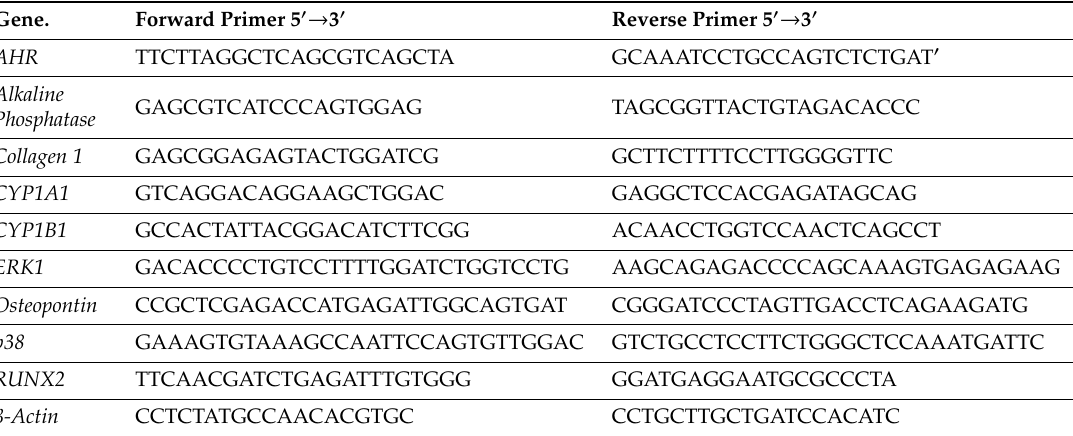
Table 1. List of primer sequences used for qRT-PCR analysis in this study.